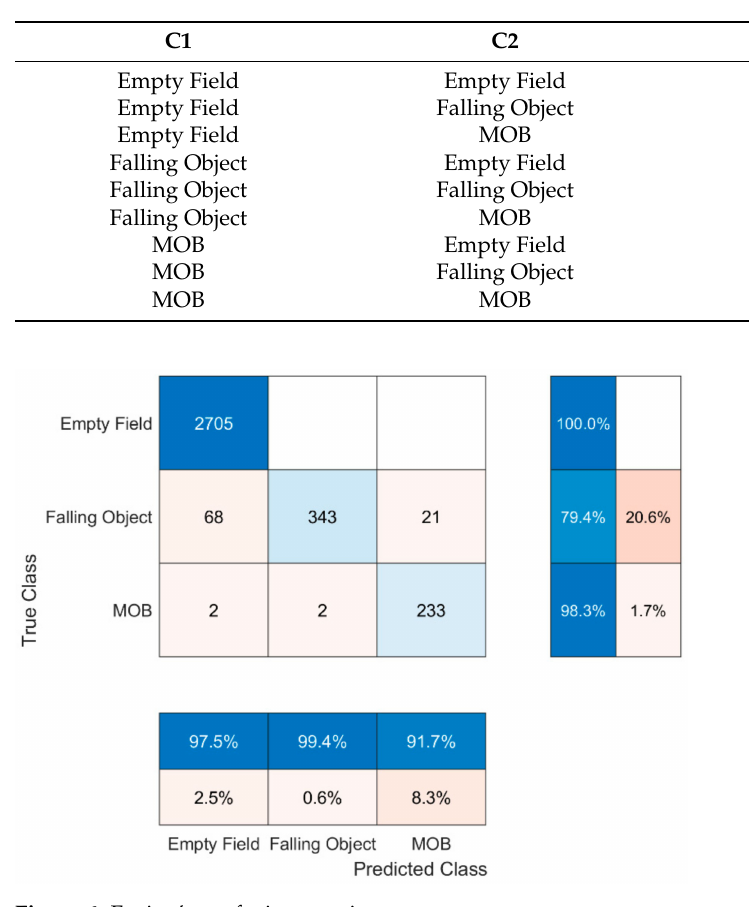
Table 3. Decisions taken from the fusion of the radar sensors.